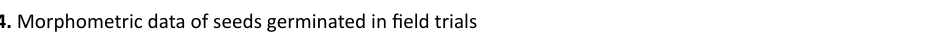
Table 4. Morphometric data of seeds germinated in field trials Growth Control